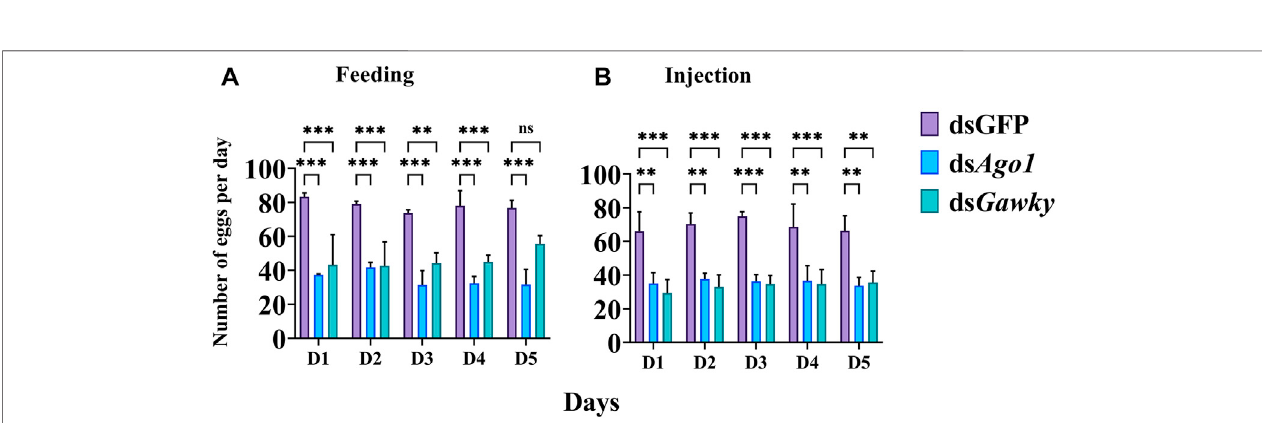
FIGURE 5 | Effects of Ago1 and Gawky RNAi on egg-laying of Z. cucurbitae . (A) 3 rd instar larvae were fed with dsGFP, ds Ago1 , and ds Gawky , respectively. For each treatment, one treated female was crossed with two WT males and the number of laid eggs was recorded for fi ve consecutive days and averaged. (B) Embryos wereinjectedwithdsGFP,ds Ago1 ,andds Gawky .Foreachtreatment,onetreatedfemalewascrossedwithtwoWTmalesandthenumberoflaideggswasrecordedfor fi ve consecutive days and averaged. The bars represent the mean ± SD with three biological replicates. The asterisks above the bars represent signi fi cant differences between the control and treatment groups (* p < 0.05; ** p < 0.01; *** p ≤ 0.001, ns: not signi fi cant).